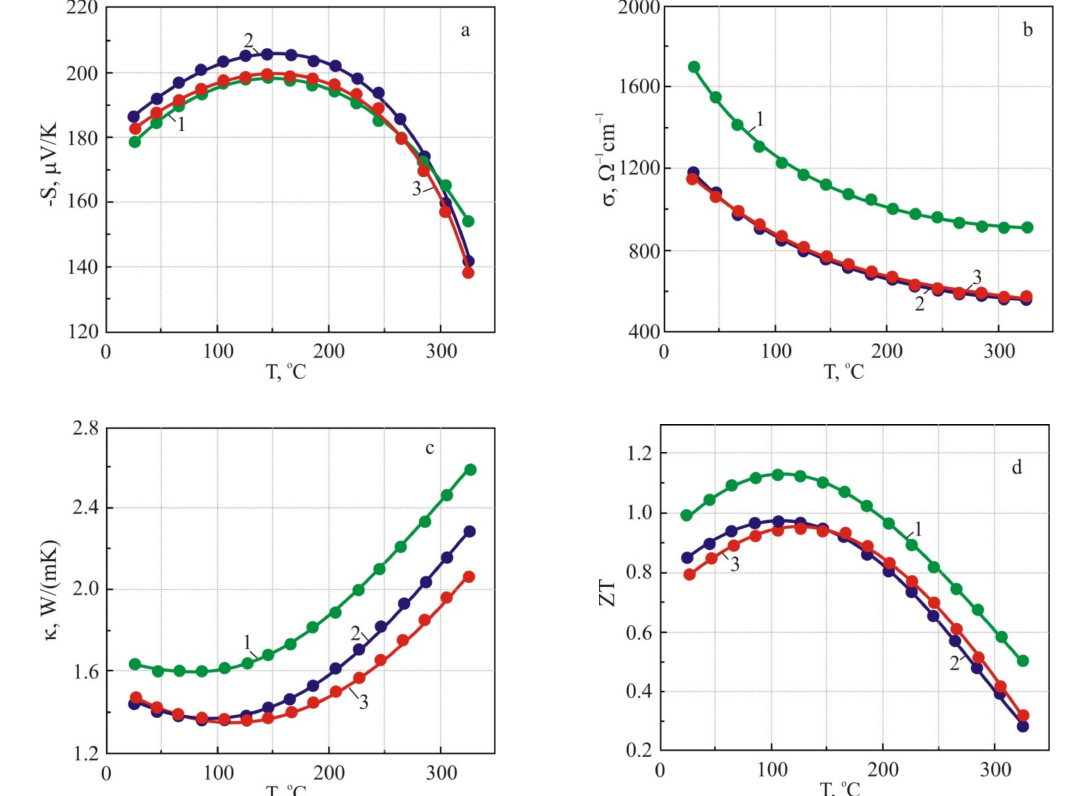
Figure 8. The temperature dependence of Seebeck coefficient ( a ), electrical conductivity ( b ), thermal conductivity ( c ), and the dimensionless figure of merit ZT ( d ) over 30–300 ◦ C temperature range for n -type Bi 2 Te 3 − x Se x samples, fabricated by hot extrusion. 1—Bi 2 Te 2.7 Se 0.3 . 2—Bi 2 Te 2.55 Se 0.45 . 3—Bi 2 Te 2.4 Se 0.6